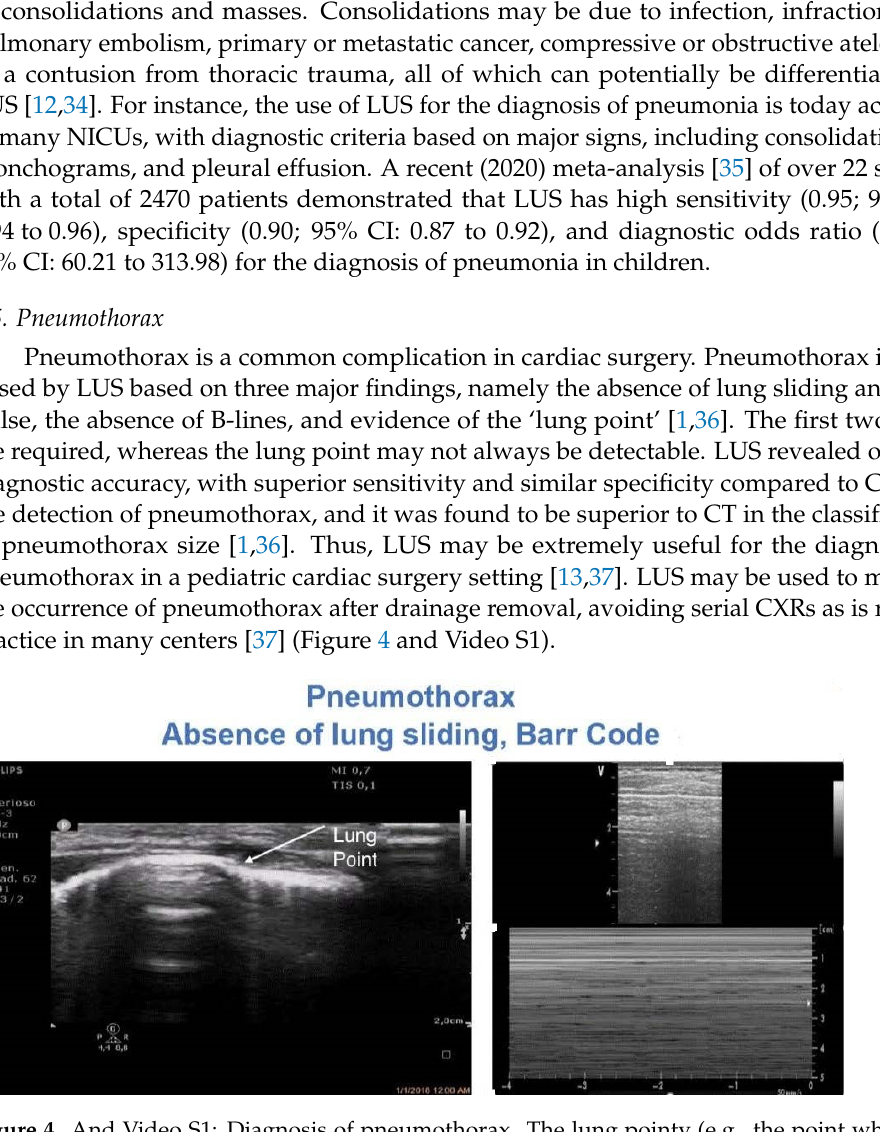
Figure 4. And Video S1: Diagnosis of pneumothorax. The lung pointy (e.g., the point where the pleura stops its movement) is highlighted on the left side. On the right side, the typical Barcode sign on M-mode is shown.